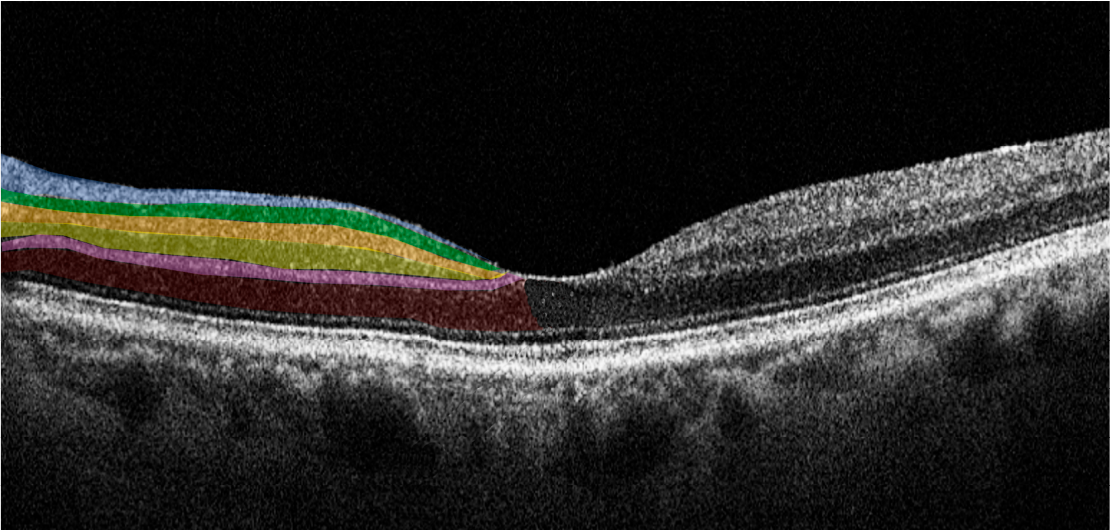
Figure 2. Horizontal spectral domain optical coherence tomography (SD-OCT) cross-sectional scan passing through the fovea. The various retinal layers are shown with added color overlayers on the left side as follows: blue: retinal nerve fiber layer; green: ganglion cell layer; orange: inner plexiform layer; yellow: inner nuclear layer; pink: outer plexiform layer; red: outer nuclear layer. The right side shows original SD-OCT output in scales of grey.